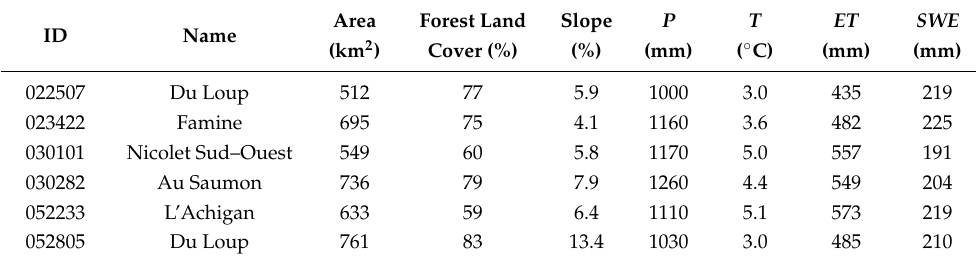
Figure 1. Localization study area. Table 1. Main catchment characteristics and climatology. P : total precipitation. T : mean annual temperature. ET: evapotranspiration. SWE : snow water